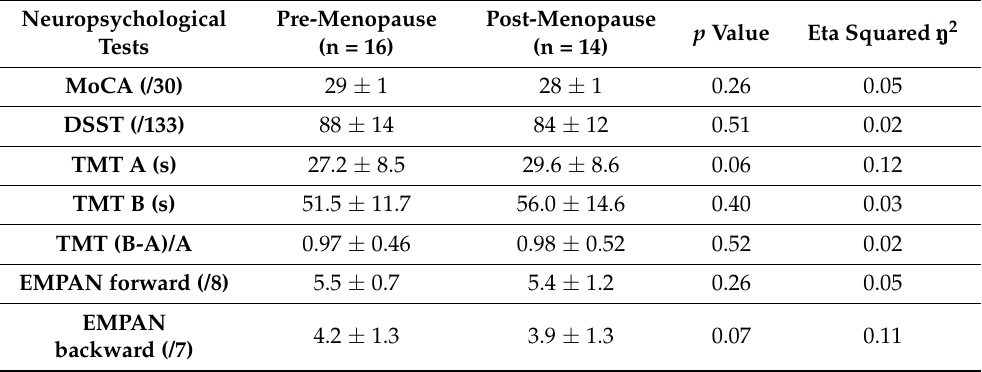
Table 2. Neuropsychological variables.